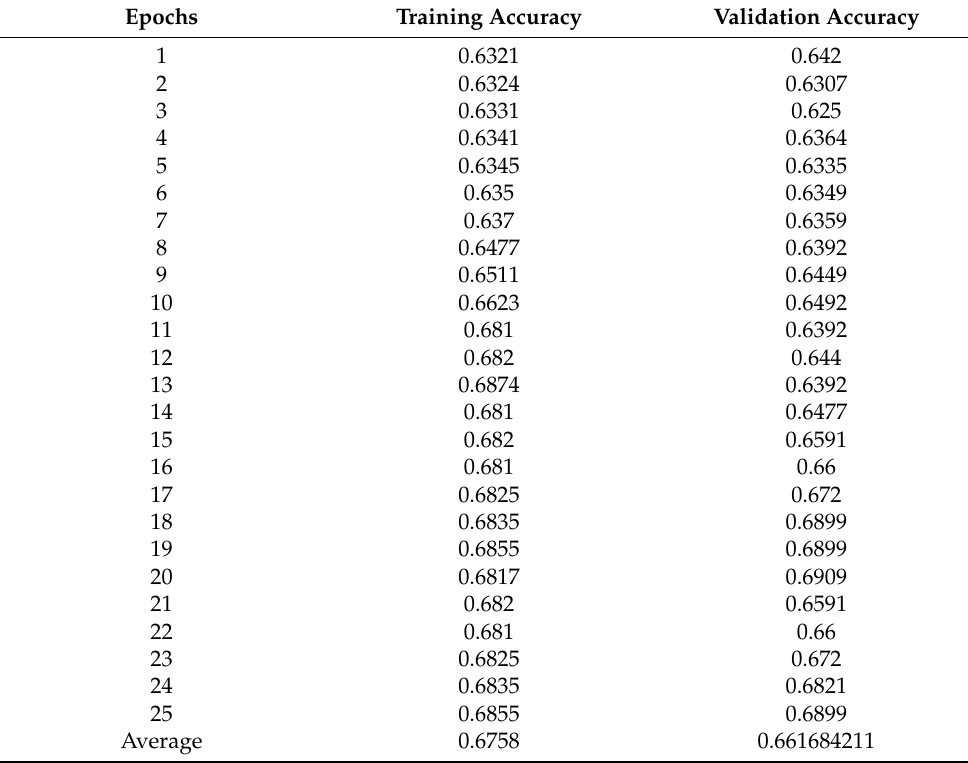
Table 3. Training and validation accuracies of the MobileNet-V2 model used in the current research study.